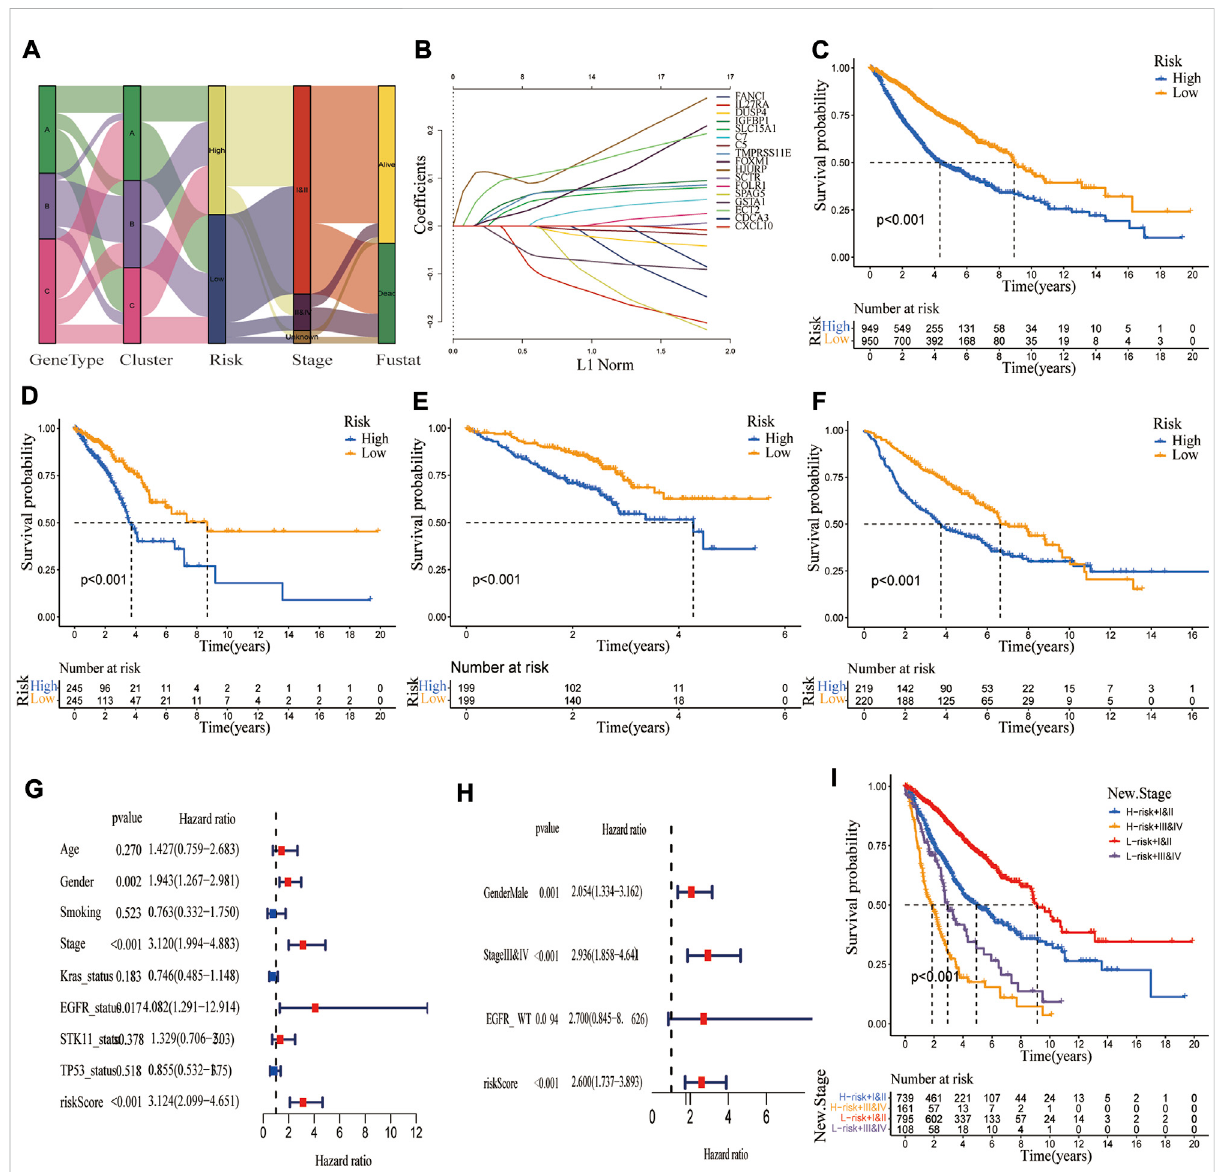
FIGURE 6 ConstructionofaCRG_scoresignatureinthemergedcohort and validation inthree independent datasets. (A) The alluvial diagramshowed the changes in LUAD molecular clusters, genetic subtypes, CRG_score, TNM stage, and survival status. (B) The Lasso regression analysis identi fi ed 17LUAD prognosis-related genesto constructtheCRG_scoresignature.Thedifference inoverall survival between high andlow CRG_scoregroups in (C) mergedcohort; (D) TCGA; (E) GSE72094; (F) GSE68465( p < 0.001). (G,H) UnivariateandmultivariateCoxregressionanalysesshowedthe prognostic value of the CRG_score in the merged cohort. (I) Kaplan Meier curve revealed the relationship among TNM stage, CRG_score, and survival